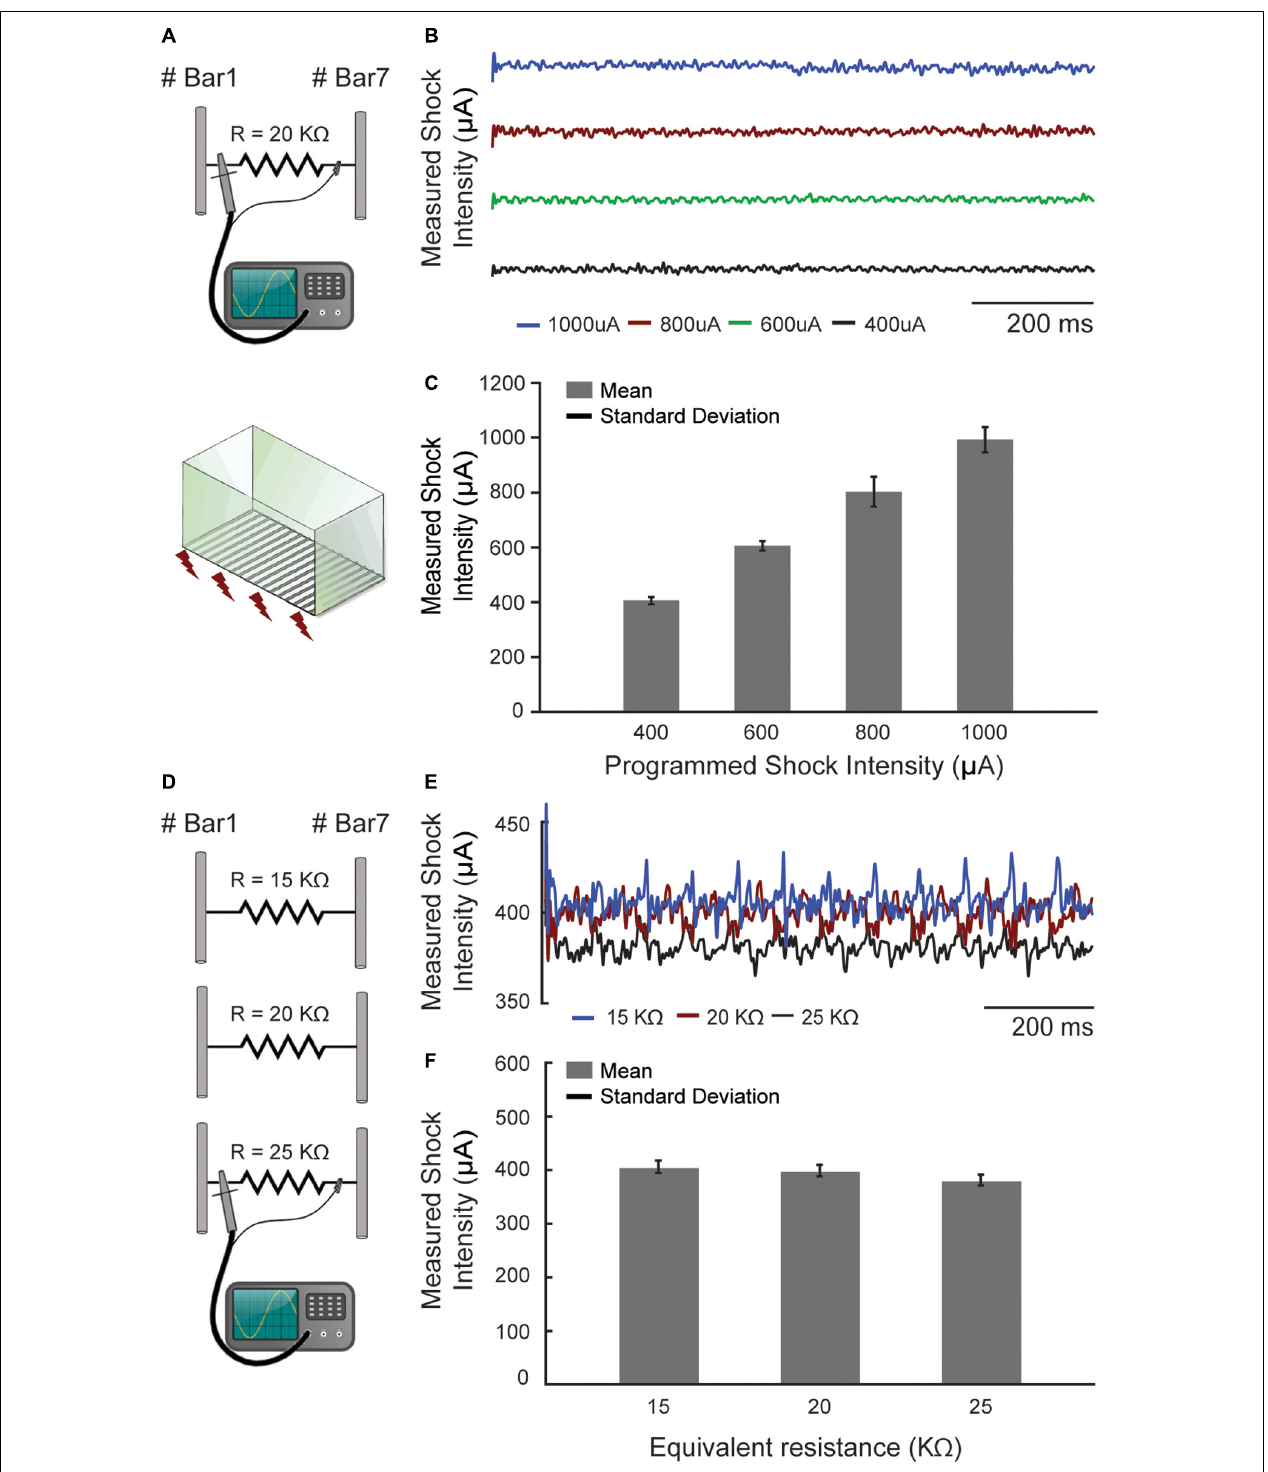
FIGURE 5 | The footshock exhibited precisely configurable patterns. (A) The footshock intensity was measured by an oscilloscope ( I = V/R) through a resistor that simulates the animal skin resistance. (B) The current measurements were made over time in four different programed shock intensities ( µ A). (C) The mean footshock intensities remaining constant and showed no significant changes. (D) The same measurement was performed with three different resistors at a programed current value to simulate the skin resistance variations. (E) The current measurements were made in one programed value (400 µ A) over time. (F) The values with a 25% deviation around the 20 k (cid:127) caused no significant changes in the programed shock intensities (maximum ∼ 4.74%, ∼ 18 µ A, to 25 k (cid:127) ).